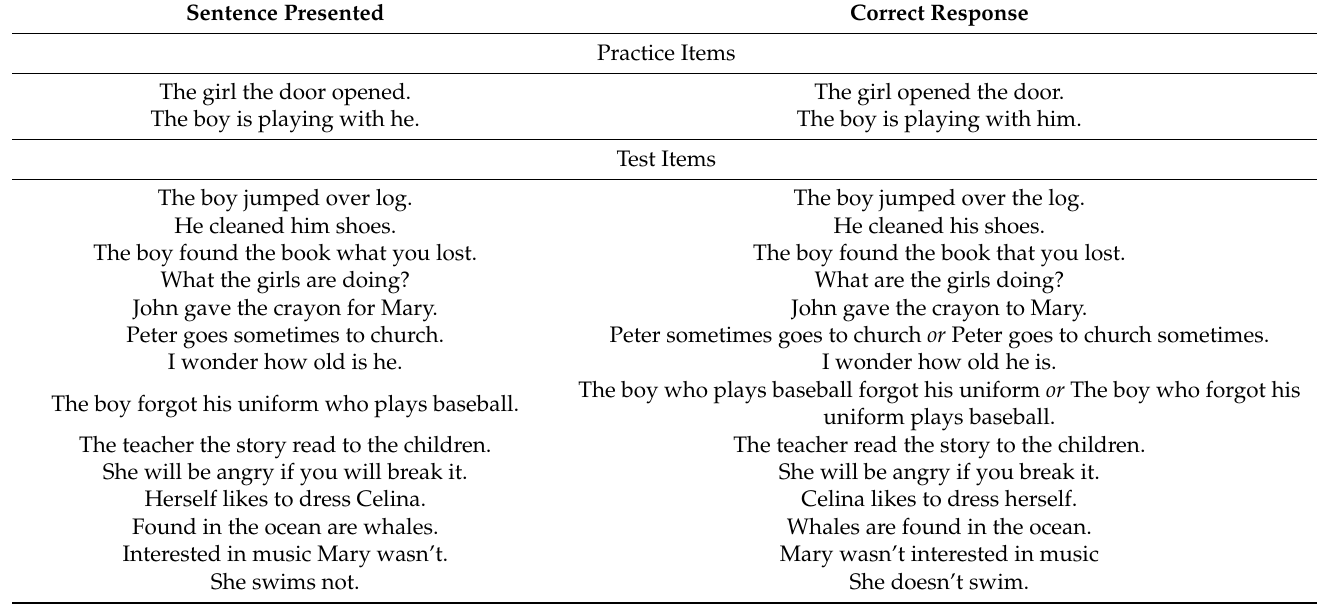
Table A1. Practice and Test Items on the English Syntactic Awareness